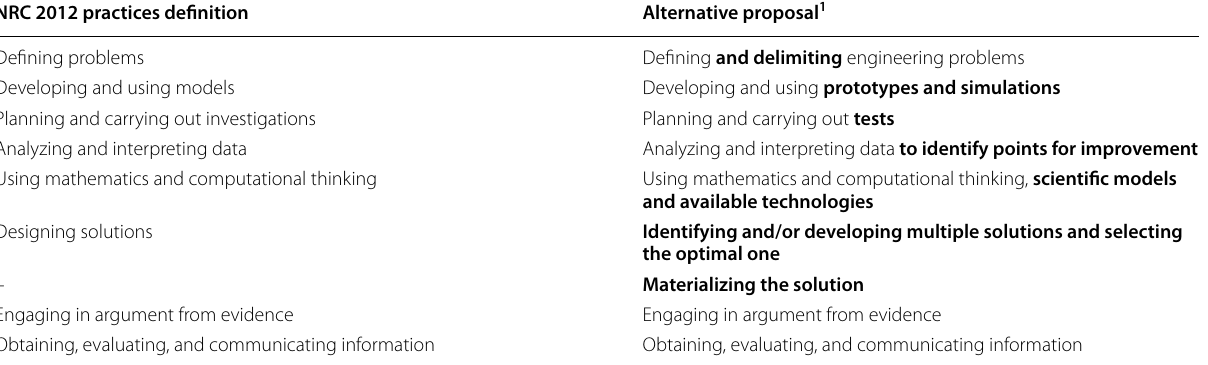
Table 3 Alternative proposal to the NRC Engineering